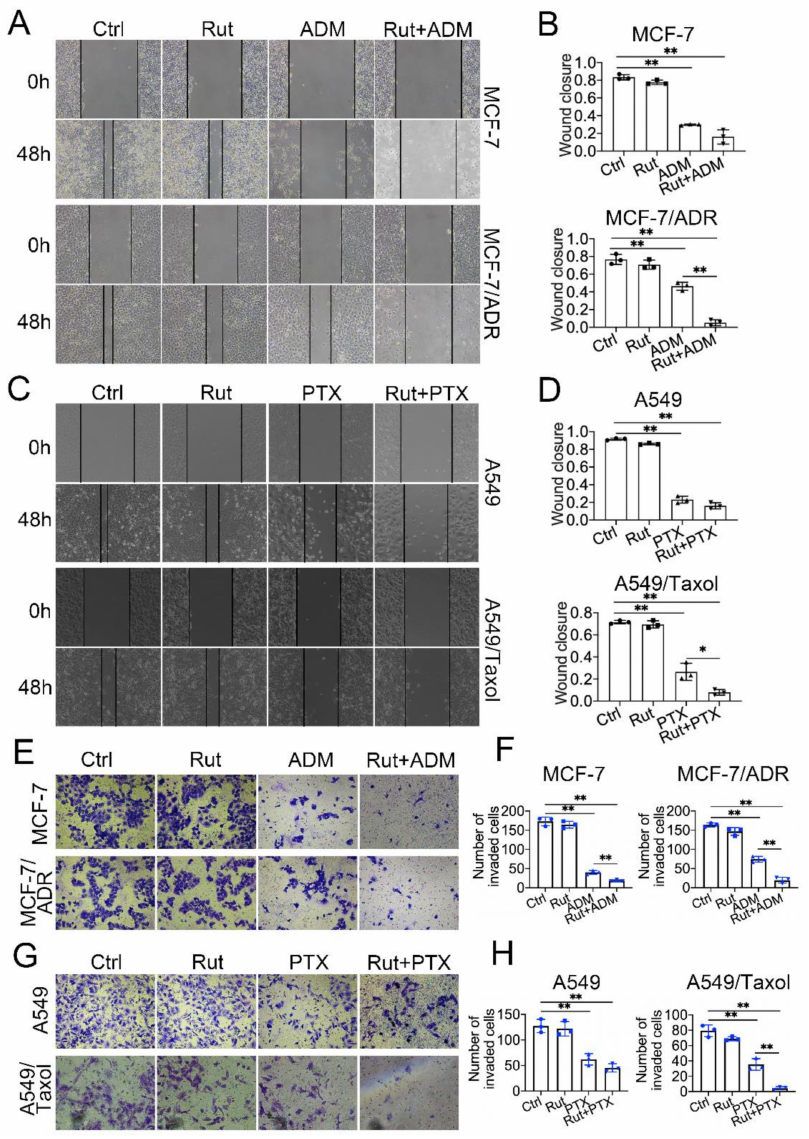
Figure 5. The effects of rutaecarpine combined with anticancer drugs on the mobility of parental and ABCB1-overexpressing cells. ( A ) Wound healing assay of MCF-7 and MCF-7/ADR cells following treatment with 20 µ M rutaecarpine and 500 nM or 5 µ M adriamycin alone or in combination, and ( B ) the quantification of the wound closure area. Magnification, 100. Data are mean SD × ± ( n = 3). ( C ) Wound healing assay of A549 and A549/Taxol cells following treatment with 20 µ M rutaecarpine and 500 nM or 5 µ M paclitaxel alone or in combination, and ( D ) the quantification of the wound closure area. Magnification, 100. Data are mean SD ( n = 3). ( E ) Migration and × ± invasion assays of MCF-7 and MCF-7/ADR cells following treatment with 20 µ M rutaecarpine and 500 nM or 5 µ M adriamycin alone or in combination for 48 h, and ( F ) the results of the migration and invasion assays were statistically analyzed. Data are mean SD ( n = 3). ( G ) Migration and invasion ± assays of A549 and A549/Taxol cells following treatment with 20 µ M rutaecarpine and 500 nM or 5 µ M paclitaxel alone or in combination for 48 h, and ( H ) the results of the migration and invasion assays were statistically analyzed. Magnification, 100. Data are mean SD ( n = 3). * p < 0.05 and × ± ** p < 0.01. Rut, rutaecarpine; ADM, adriamycin; PTX,